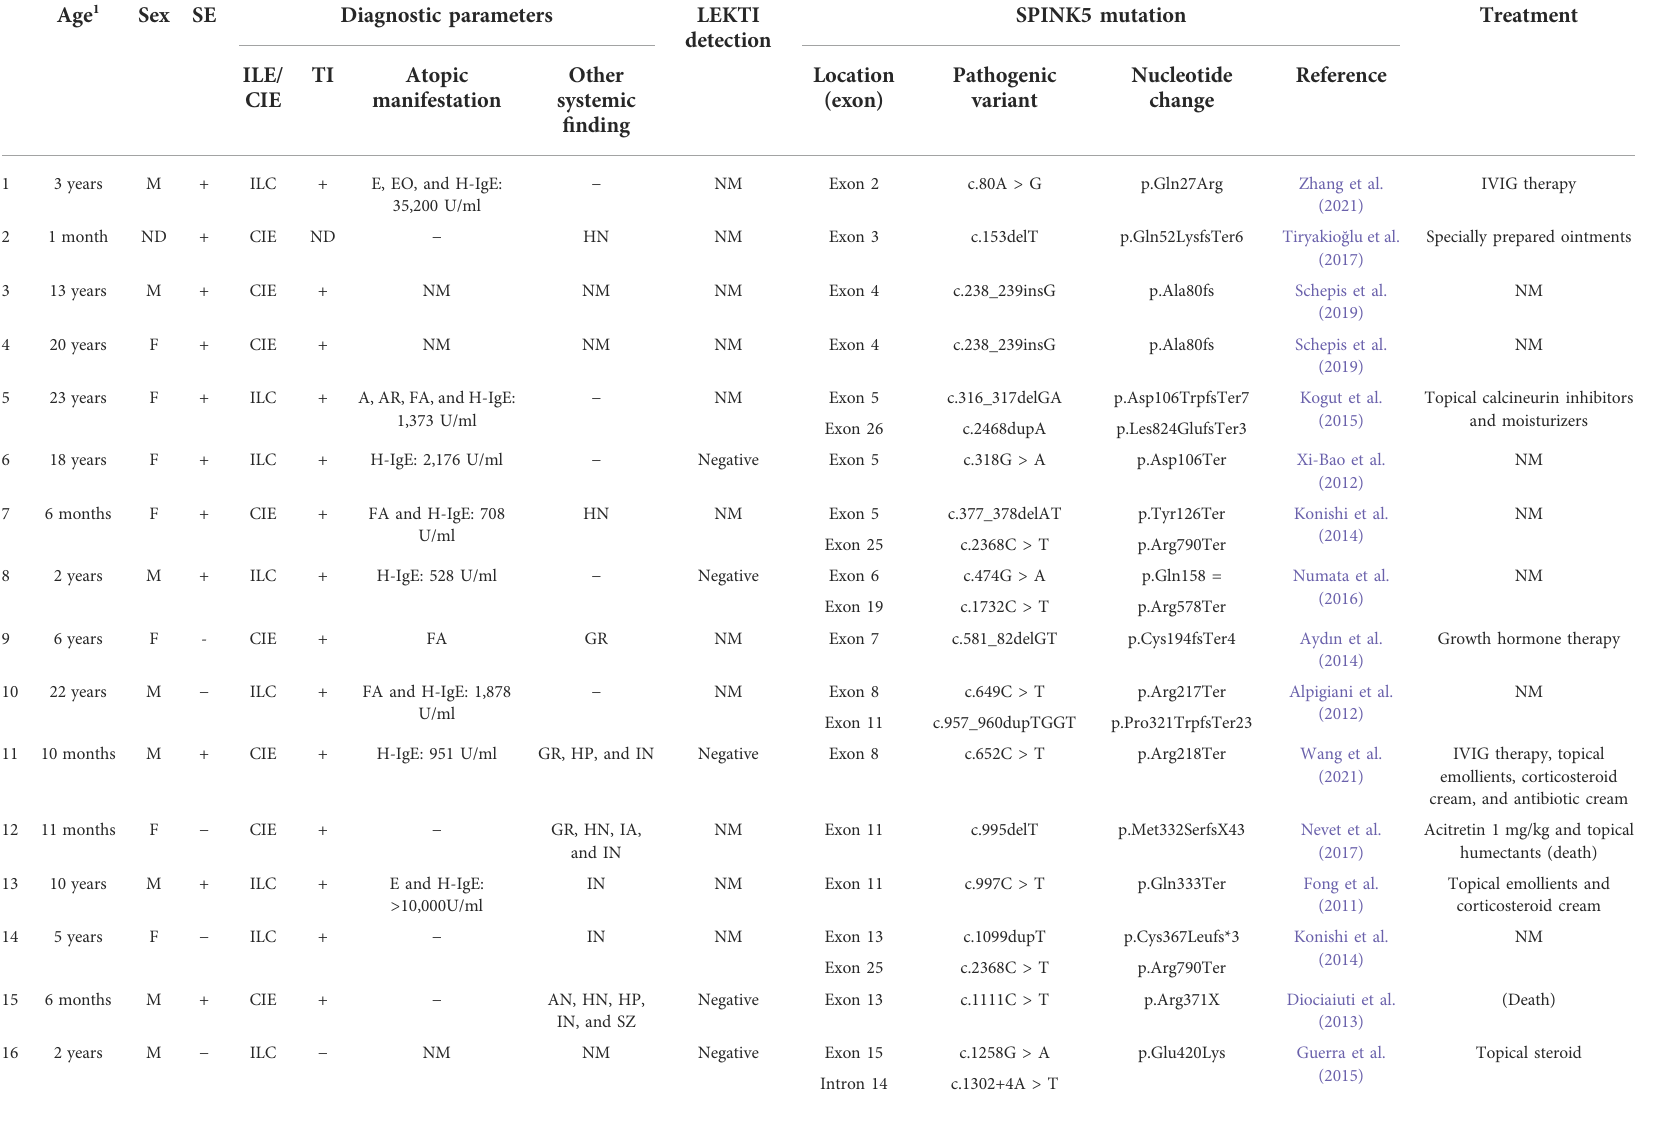
TABLE 1 Summary of the clinical phenotype and genotype from patients with Netherton